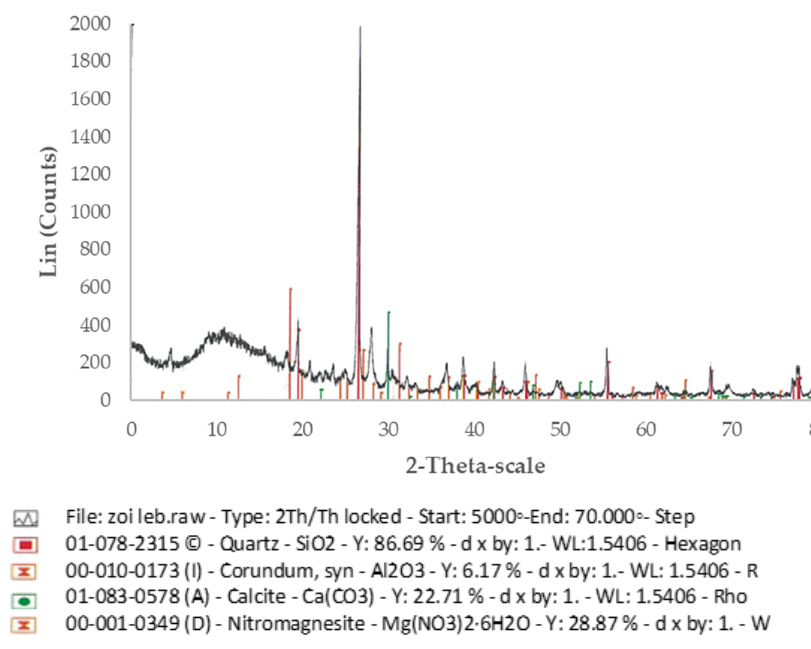
Figure 3. XRD diffractograms of TZ clay.